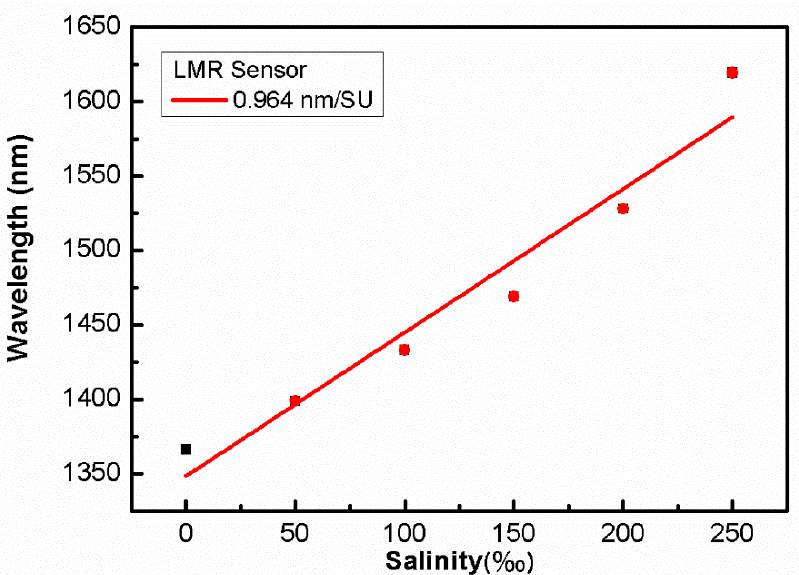
Figure 10. The sensitivity of the LMR type salinity sensor.